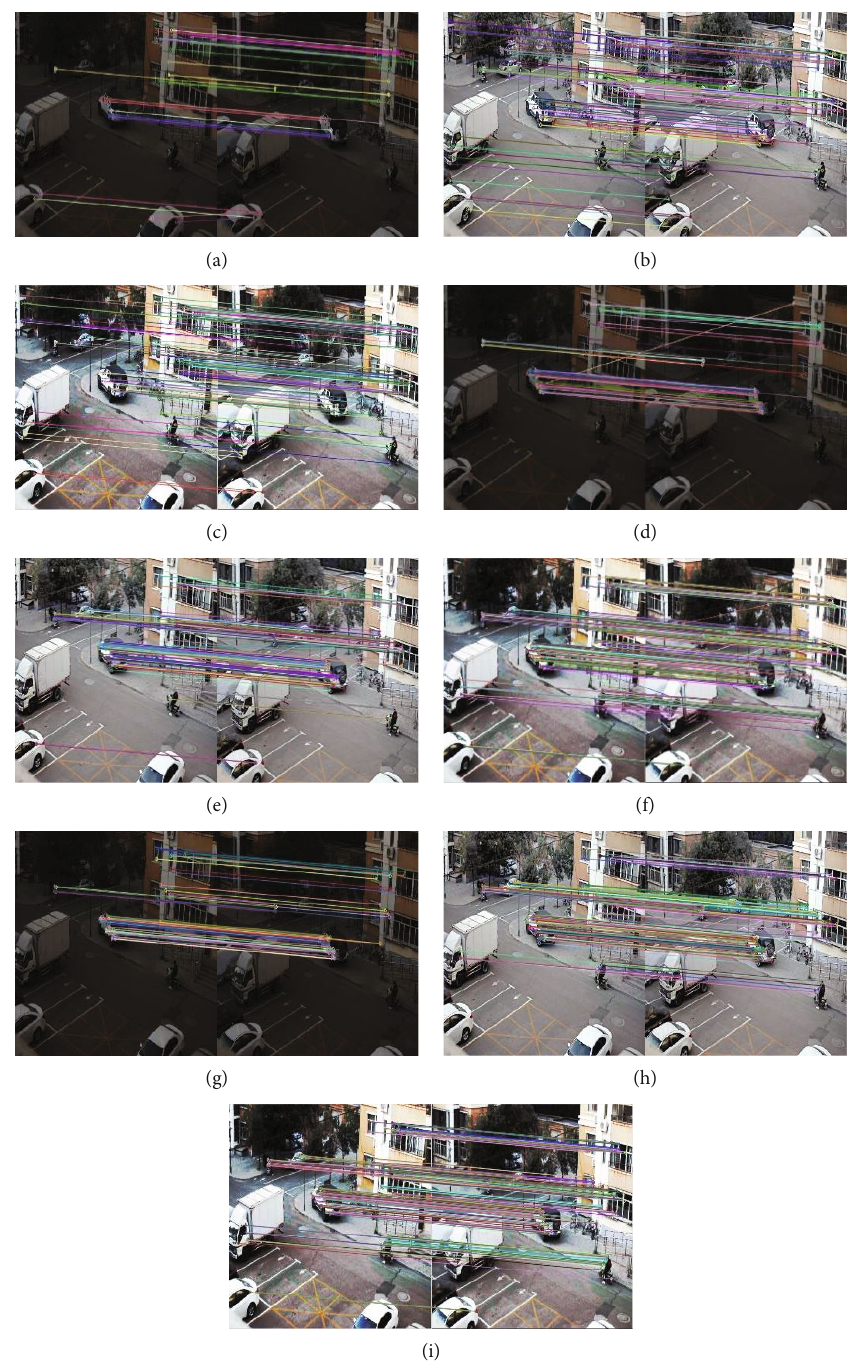
Figure 9: Scene 3: (a) SURF; (b) SURF+MSRCR; (c) SURF+Improved MSR; (d) ORB; (e) ORB+MSRCR; (f) ORB+Improved MSR; (g) ORB+PROSAC; (h) ORB+PROSAC+MSRCR; (i) method in this